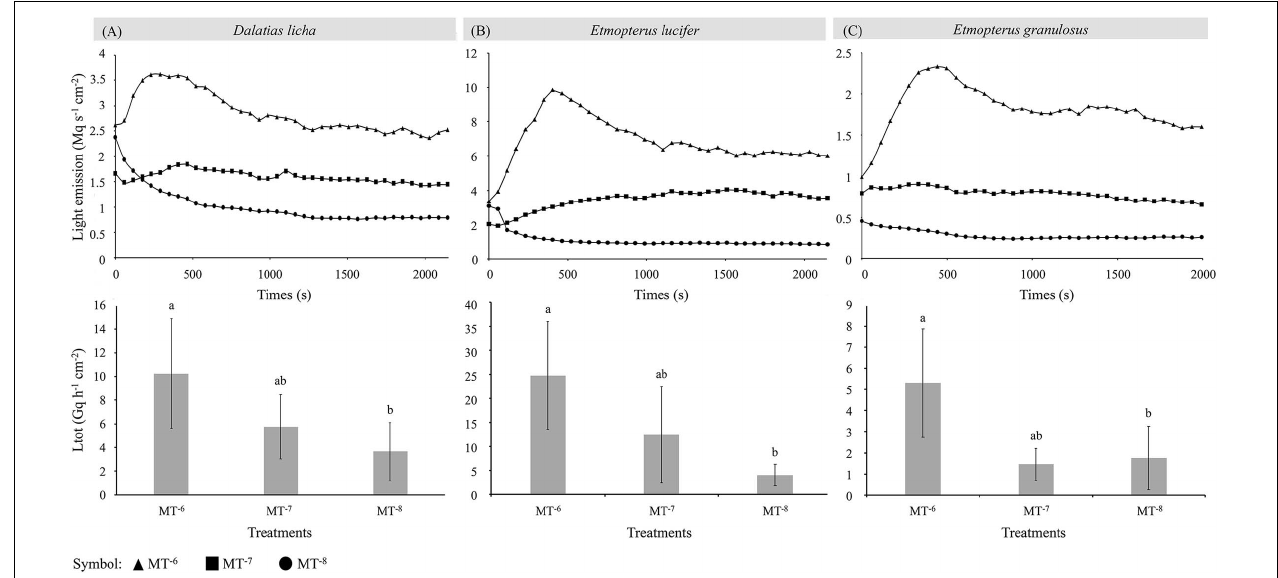
FIGURE 5 | Effect of MT on the studied species luminescence. Time course of the mean light emissions (Mq s − 1 cm − 2 ) and total amount of light produced (Gq h − 1 cm − 2 ) from ventral skin patches under hormonal treatments (MT 10 − 8 to 10 − 6 mol L − 1 ) for (A) Dalatias licha ( n = 10), (B) Etmopterus lucifer ( n = 7), and (C) Etmopterus granulosus ( n = 4). Different lettering indicates statistical differences [Kruskal-Wallis ANOVA: D. licha χ 2 (3) = 23.95, P -value = 2.56 × 10 − 5 ; E. lucifer χ 2 (3) = 23.823, P -value = 2.72 × 10 − 5 ; E. granulosus χ 2 (3) = 8.5368, P -value = 0.0361]. Error bars correspond to SEM.